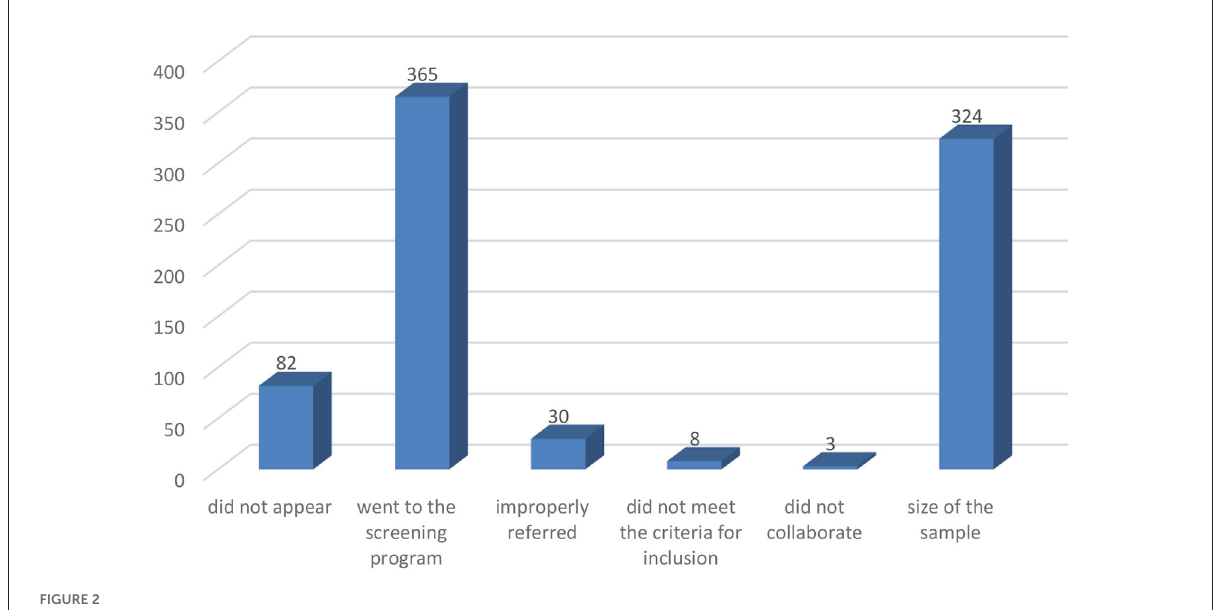
FIGURE2 Distribution of the subjects enrolled for screening program.